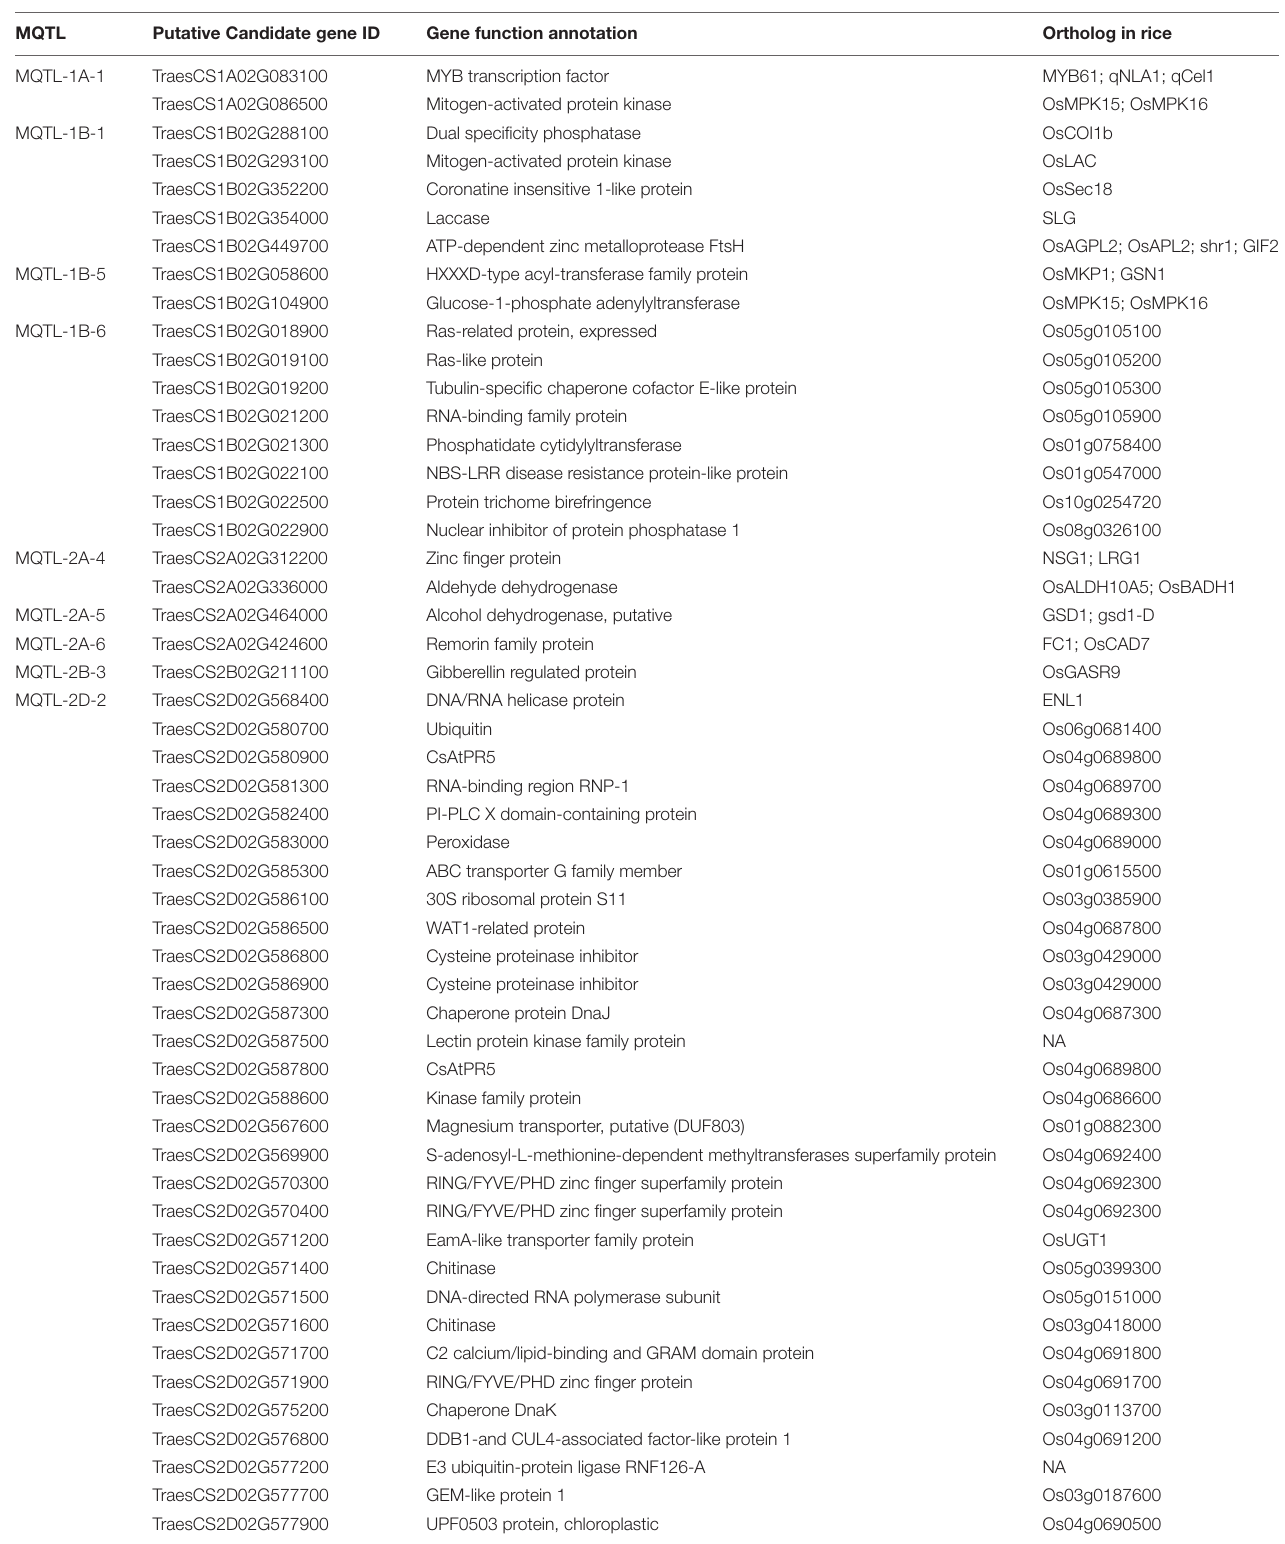
TABLE 2 | Summary of 134 putative candidate genes exhibiting significant expression (TPM > 2) within MQTLs. MQTL Putative Candidate gene ID Gene function